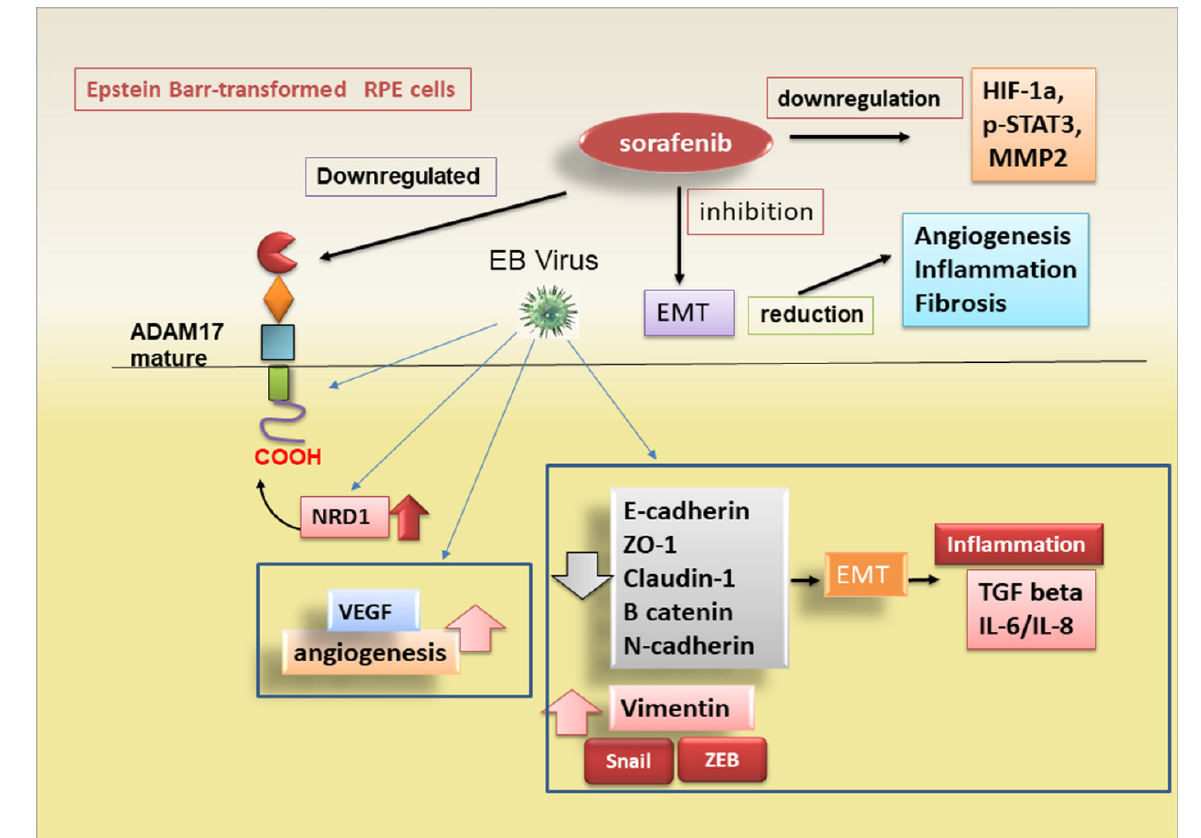
Figure 3. ADAM17 mediates the modulation of EMT in retinal pigment epithelium. Epstein Barr-transformed adult retinal pigment epithelium (RPE) cells express several mesenchymal markers and secrete TGF- β and VEGF. These cells exhibit mesenchymal phenotype features and show a considerable reduction in epithelial markers expression. In these transformed cells was used the multi-kinase inhibitor Sorafenib (SRF) to study the effects on the regulation of EMT by ADAM17. SRF is able to downregulate migration-related signalling molecules, such as HIF-1a, p-STAT3 and MMP2 and, therefore, downregulates the events involved in EMT programme. The expression of mature ADAM17 in RPE/EBV cells was downregulated after treatment with SRF through the regulatory activity of nardilysin (NRD-1).